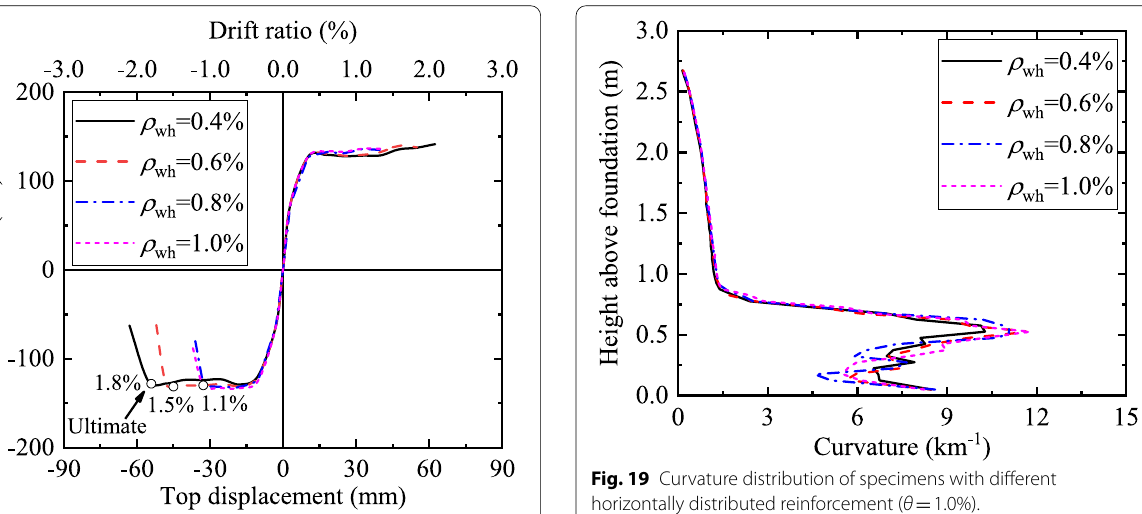
Fig. 17 Skeleton curves of specimens with different horizontally distributed reinforcement.